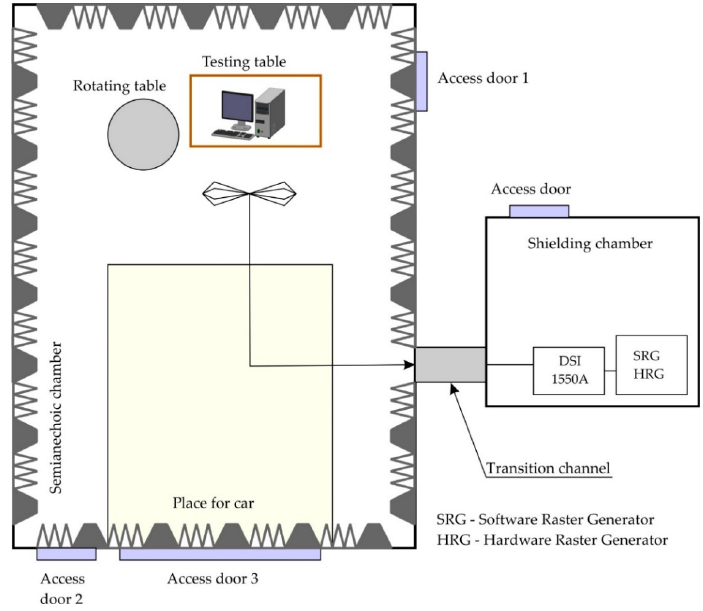
Figure 2. Communication Institute test bed.